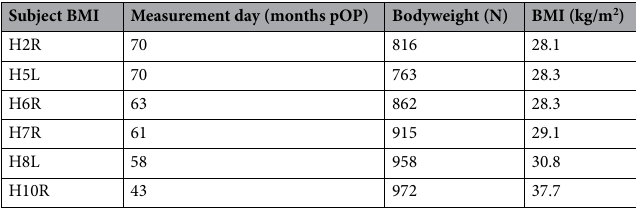
Table 2. Subjects participating in the long-term